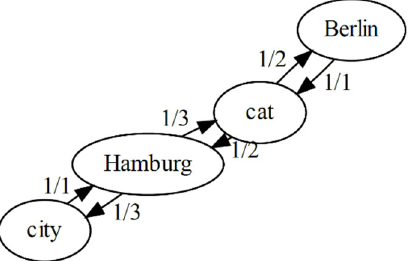
Figure 1. Extraction of association rules from the sample text: “We live in Hamburg. We find Hamburg to be a nice city. Our cat is with us in Hamburg. The cat ran away to Berlin”.